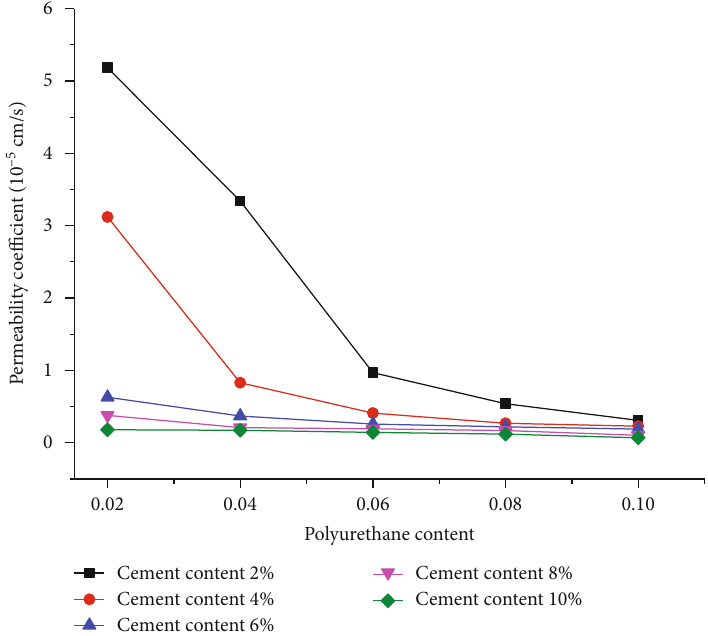
Figure 9: E ff ect of cement and polyurethane content on permeability coe ffi cient of